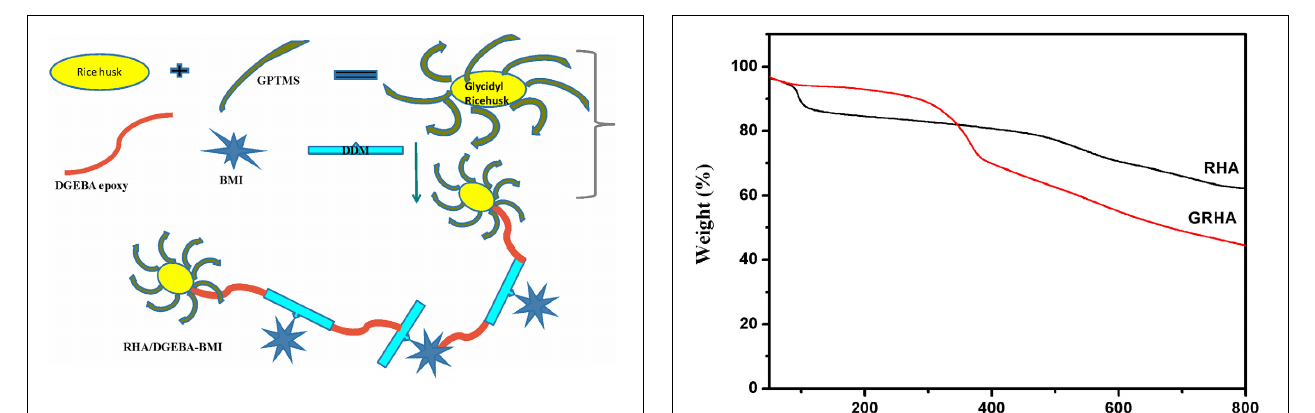
FIGURE 2 | Preparation of surface functionalized rice husk ash reinforced (GRHA-EP) nanocomposites (Graphical abstract).